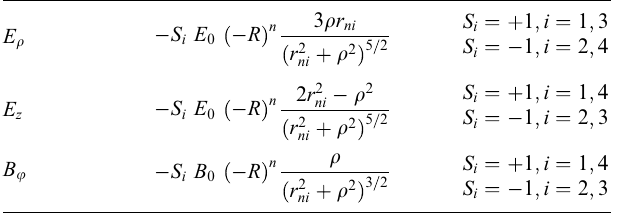
Table 5. Layer-2 secondary field terms for the